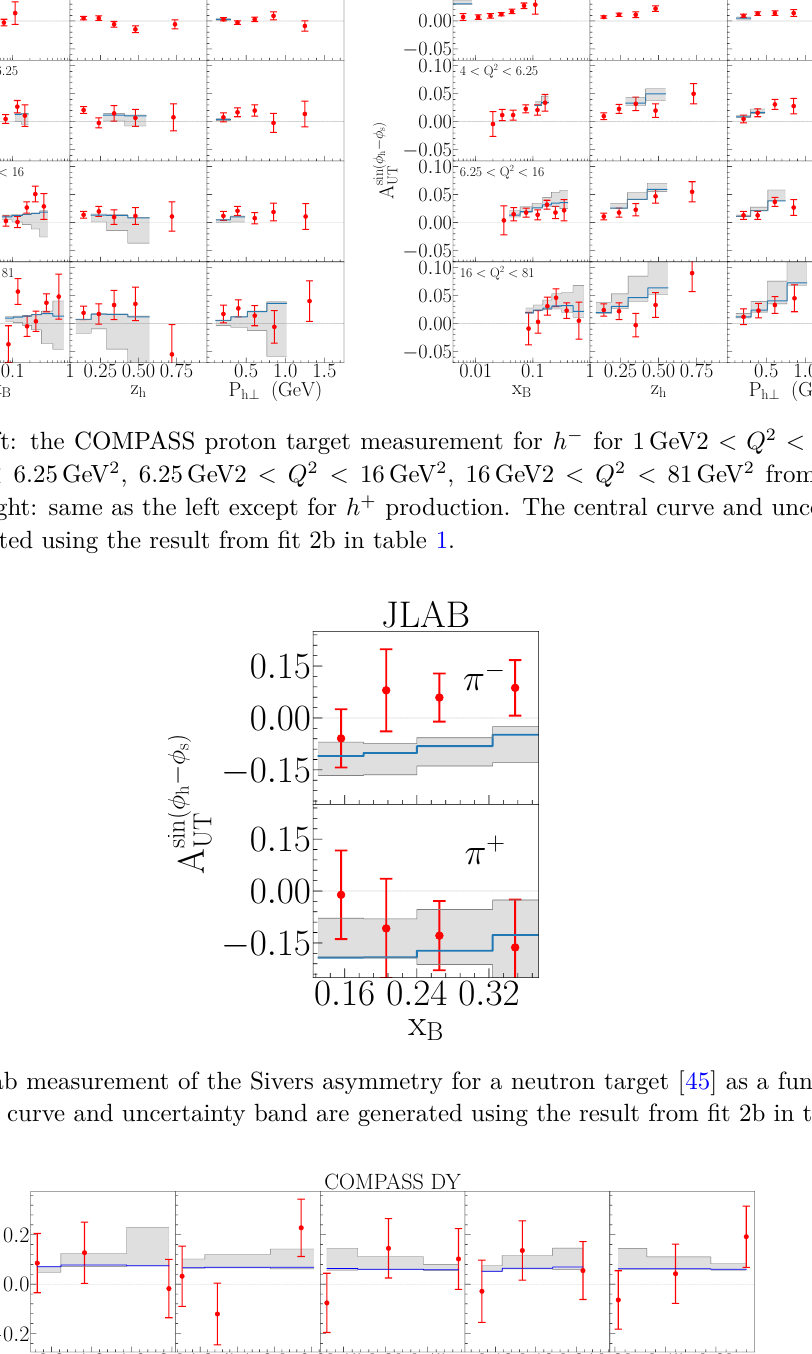
0 . − 0 . 8 1 . 2 1 . 6 2 . 0 q (GeV) ⊥ Figure 19 . COMPASS Drell-Yan measurement for π − - p collision [46] as a function of q ⊥ , Q , x F , x N , and x π from left to right. The central curve and uncertainty band are generated using the result from fit 2b in table